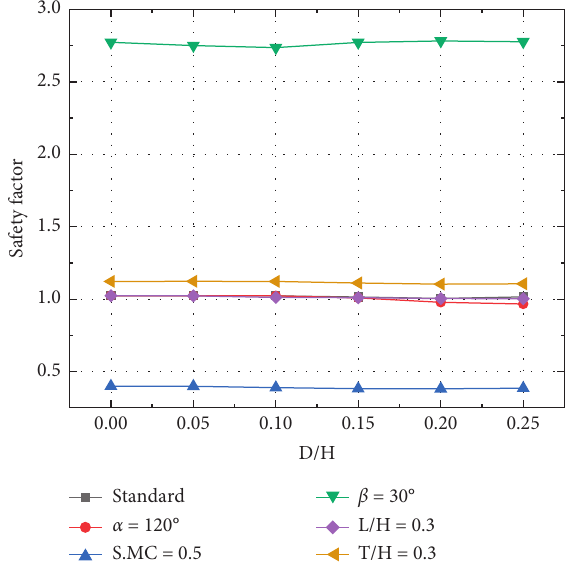
Figure 13: The influence of the distance between crack and slope on slope stability.